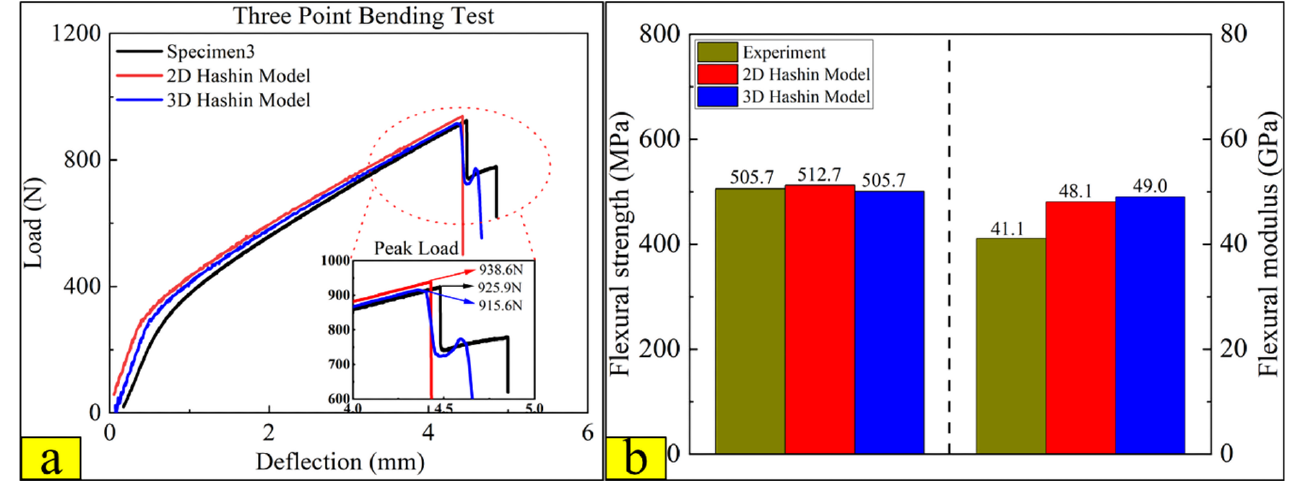
Figure 18. Comparison results between experimental, 2D, and 3D Hashin on three-point bending test: ( a ) load-deflection curves; ( b ) flexural strength and flexural modulus.